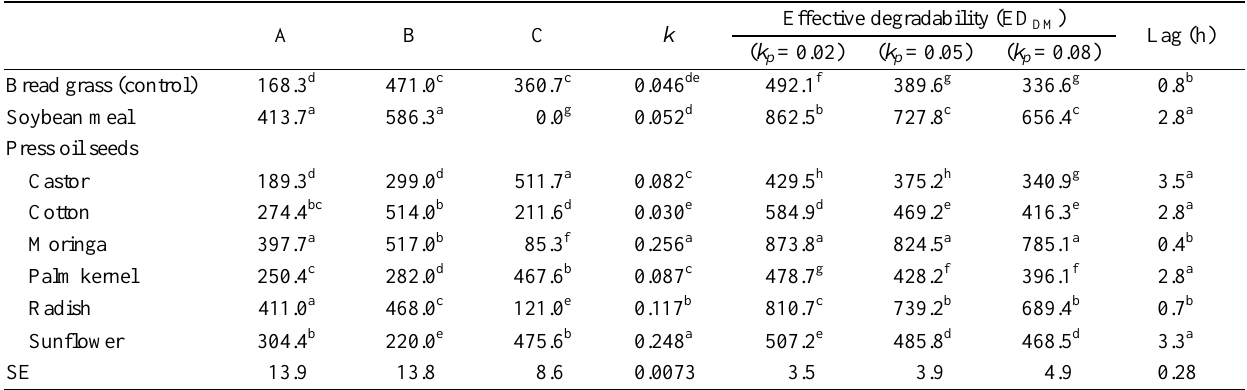
Table 2. Experimental diets dry matter degradation characteristics (in g/kg) as defined by soluble (A), degradable insoluble (B), undegradable residual ( C = 1,000-A-B) pools, fractional disappearance rate ( k , h -1 ), effective degradability (ED DM ) and lag phase (h)